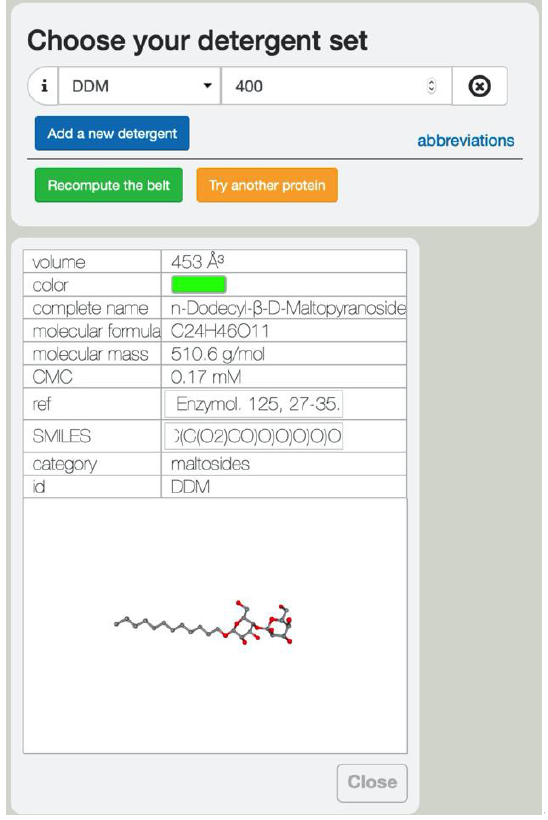
Figure 4. Detergent database. All of the information relative to each entry in the database can be obtained by clicking on the “i” next to the detergent name. The SMILES string that was used to build the molecule is available and the detergent molecule is displayed in 3D in the lower window.